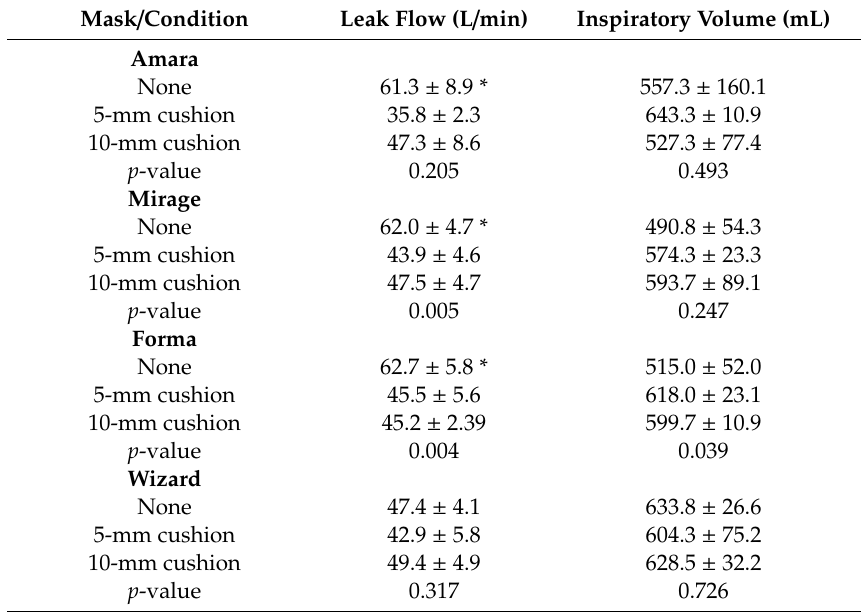
Table 1. Leak flow and inspiratory volume among the four masks with and without a cushion. Mask /